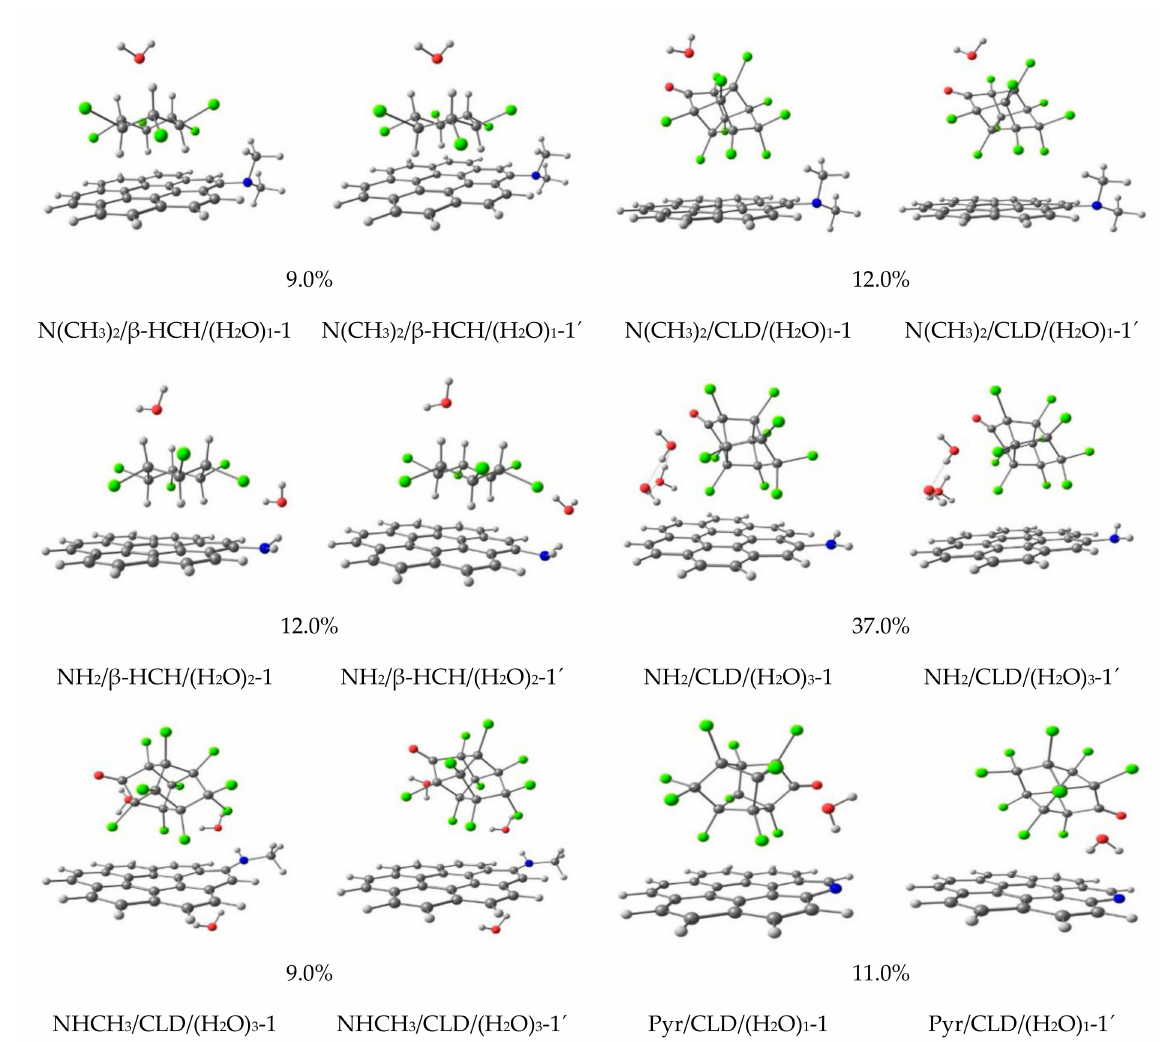
Figure 4. Distinctive minima structures and their population (%) under neutral and basic pH conditions. Numbers denote the most stable structures found at MMH-PM7 calculations, while quoted numbers account for the corresponding reoptimized structures at the MO6-2X/6-31+G(d,p) level of